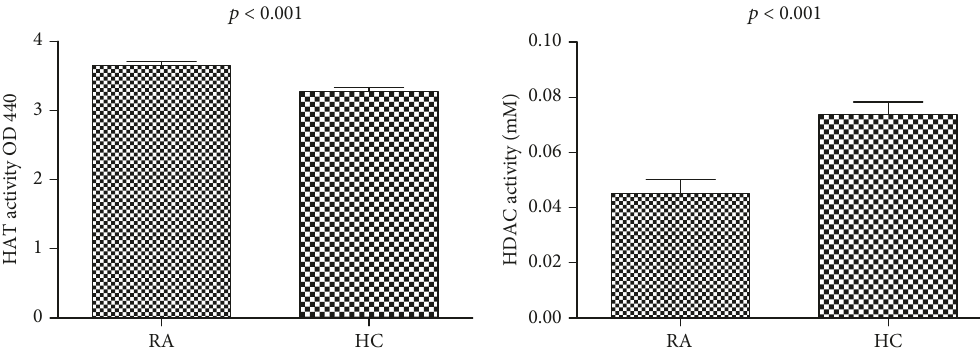
Figure 3: HAT and HDAC activities in the nuclear extracts of PBMCs in RA patients and HCs. HAT activity was signi fi cantly increased in RA patients compared with HCs. HDAC activity was signi fi cantly decreased in RA patients compared to that in